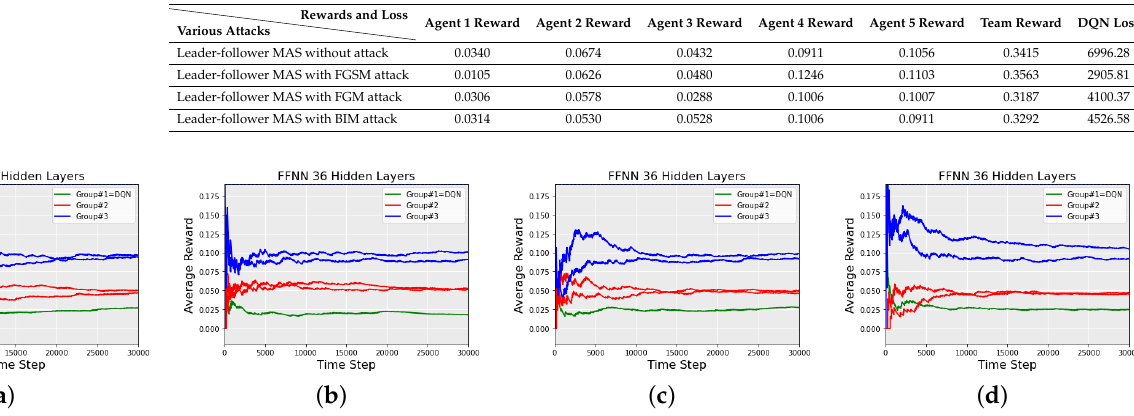
Table 5. Comparison of each agent’s average reward and DQN loss of a heterogeneous MAS, including N = 5 agents in P = 3 different clusters, during 30,000 time steps by considering time- delay and distance-based reward after adversarial attack defense Algorithm 2.